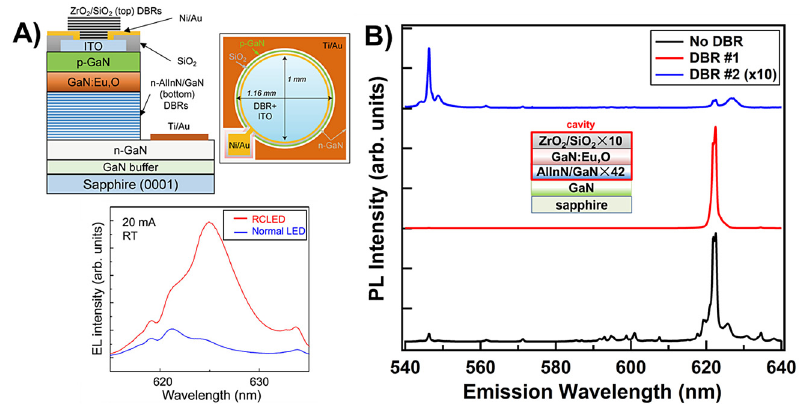
Figure 14: (A) Schematic of a resonant cavity enhanced Eu-doped GaN LED and electro- luminescence(EL)spectracomparingtheEL emission intensity for an LED with and without the cavity. [Reprinted (adapted) with permission from a study by Inaba et